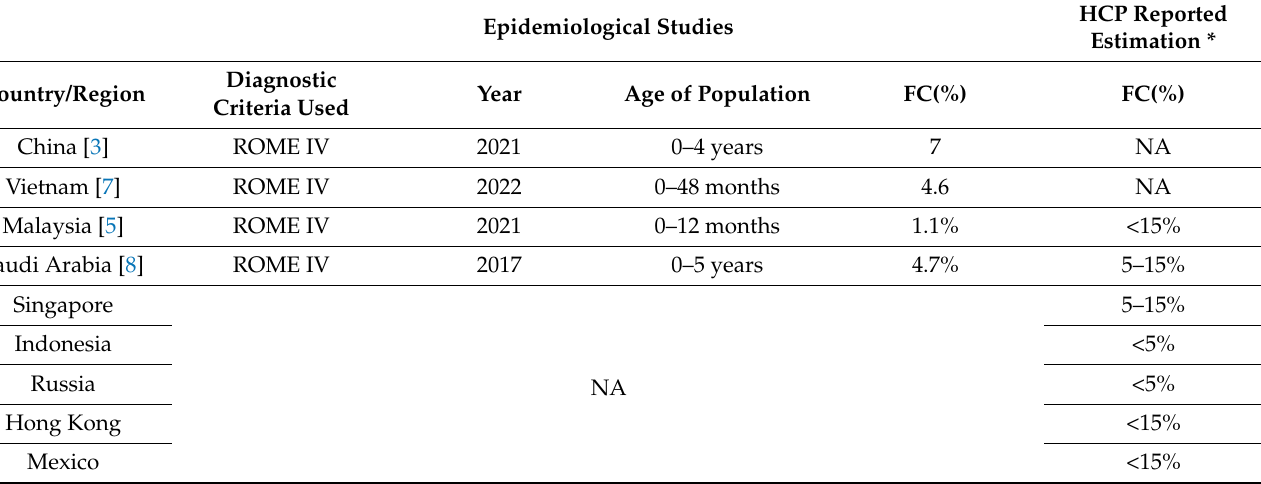
Table 3. Overview of reported prevalence of FC based on epidemiological studies as compared to the current survey results.